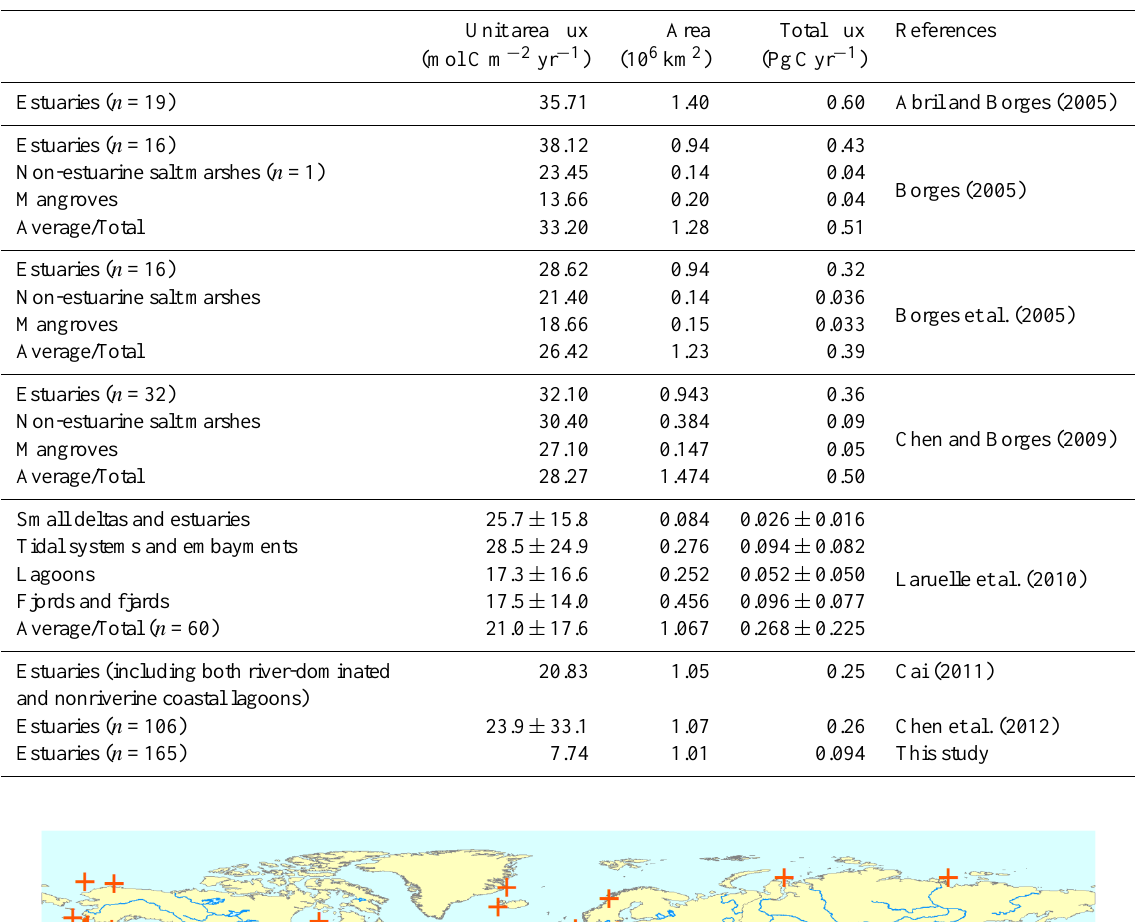
Table 4. Summary of reported total sea-to-air fluxes of CO 2 in the world’s estuaries.